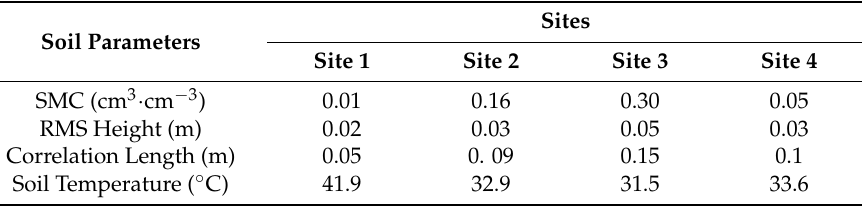
Table 3. Parameters for the rough soil surfaces measured at four different sites in Northern China (SMC: soil moisture content and RMS: root mean square of surface height).